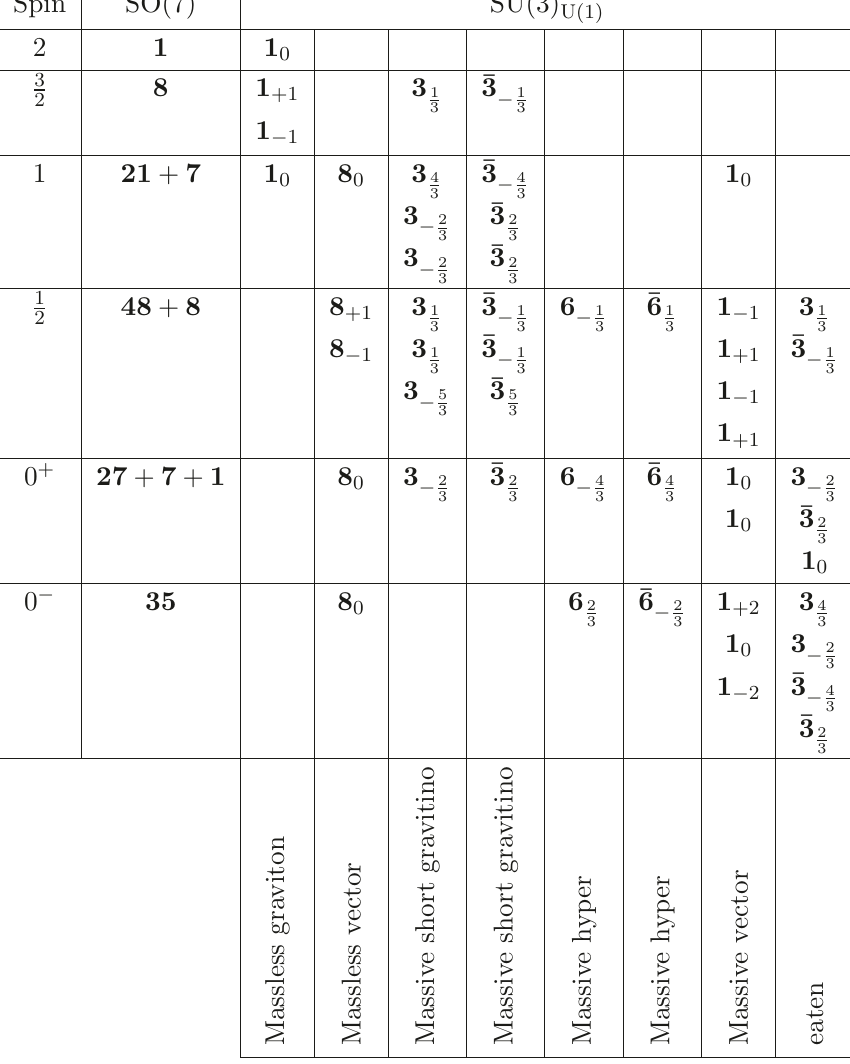
2) SU(3) spectrum of the | × = 8 theory. This coincides with scenario II of KKM N